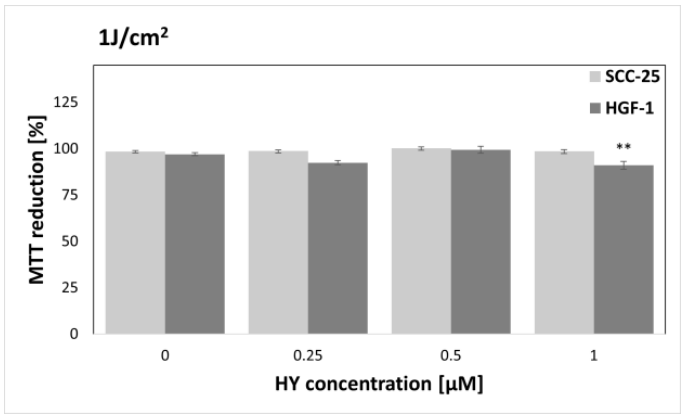
Figure 3. MTT reduction in the SCC-25 and HGF-1 lines for different HY concentrations: 0 µM, 0.25 µM, 0.5 µM, and 1 µM and light dose 0 J/cm 2 . The values represent the means ± SE. *** p < 0.01.